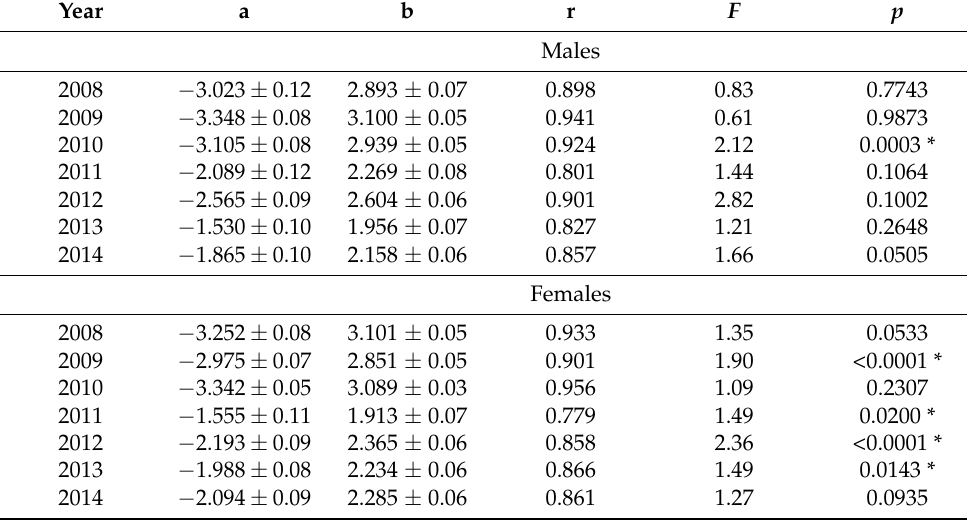
Table 1. Values of the linear regression constants a and b, estimated from the correlation of Carapace Length (CL) with Body Weight (BW) for both sexes of Nephrops, for each year of sampling (r: correlation coefficient, F and p : values from the lack-of-fit test. * designates significant lack of fit). Year a b r F p